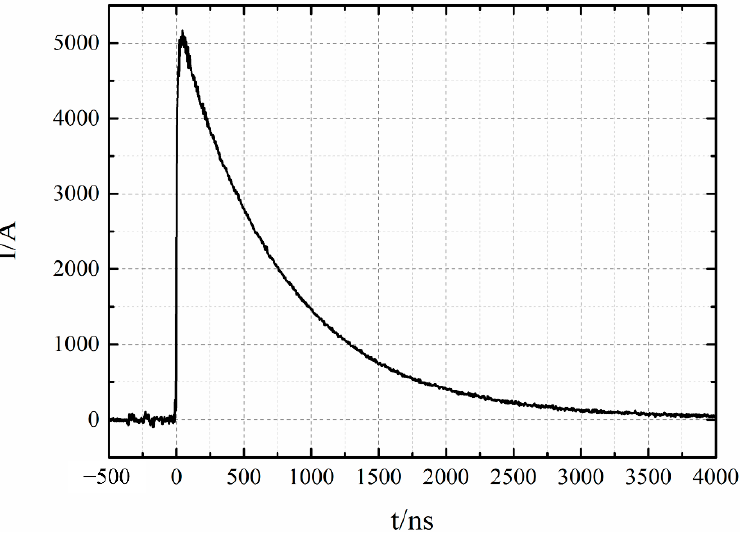
Figure 2. The short-circuit output current waveform.